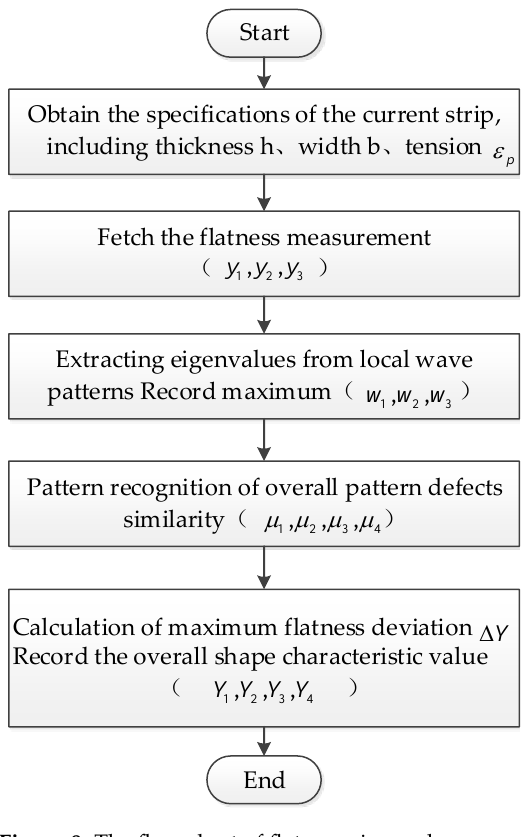
Figure 8. The flow chart of flatness eigenvalues.